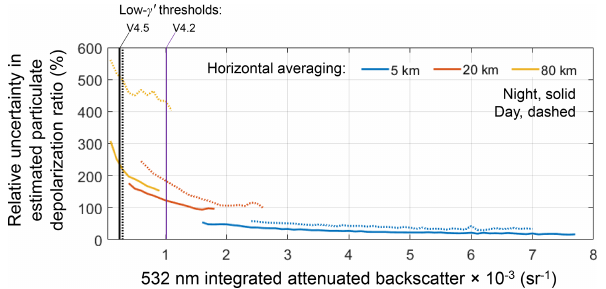
Figure 12. Average relative uncertainty in estimated particulate depolarization ratios as a function of layer-integrated attenuated ) for all stratospheric aerosol layers detected be- backscatter ( γ (cid:48) 532 tween June 2006–December 2018, segregated by horizontal aver- aging required for detection. Solid lines are nighttime detections, and dashed lines are daytime detections. Layers classified as PSA, | CAD Score | < 20 (indicating no confidence in cloud–aerosol dis- crimination), or top altitudes above 20km are excluded.